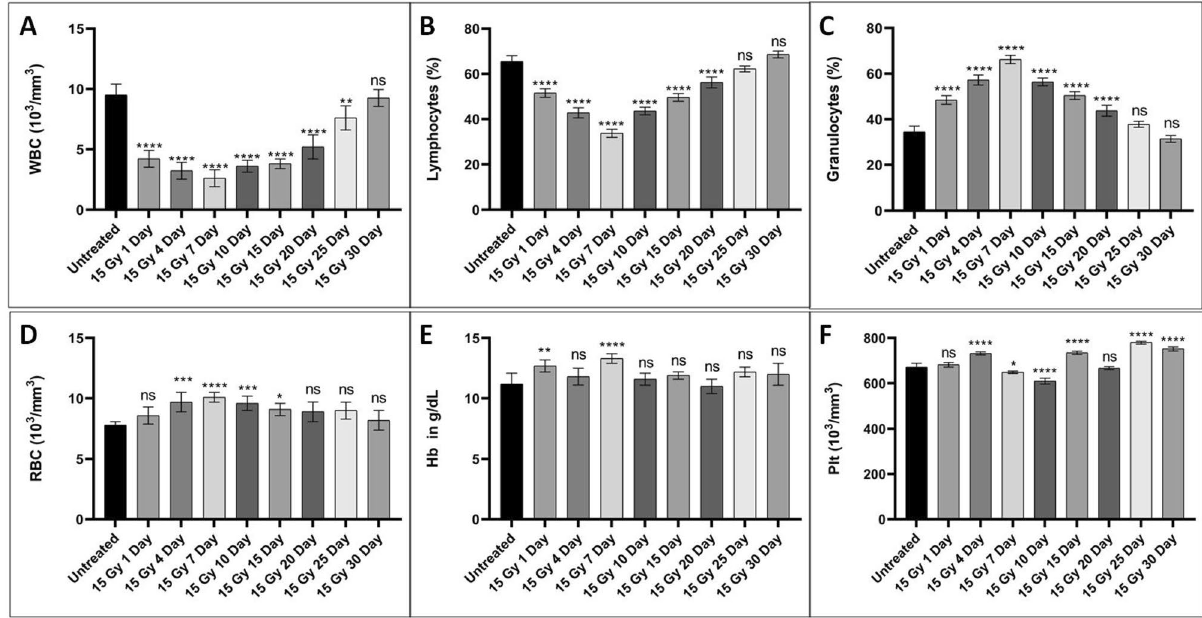
Figure 3. Cell counts in mice peripheral blood after 15 Gy localized radiation exposure at different time points. ( A ) Indicate WBC counts in the blood collected at various time points from mice. ( B , C ) represent lymphocytes and granulocytes percentage respectively. ( D ) Bars reflect RBC counts, ( E ) shows haemoglobin quantity in dL of blood, and ( F ) indicates the platelets counts at different time interval. Cells were counted using an automated haematology analyzer. The bars represent the mean ± SD of 6 animals. A value of p < 0.05 is considered statistically significant *p < 0.05, **p < 0.01, ***p < 0.001, ****p < 0.0001 , ns = not significant (p >